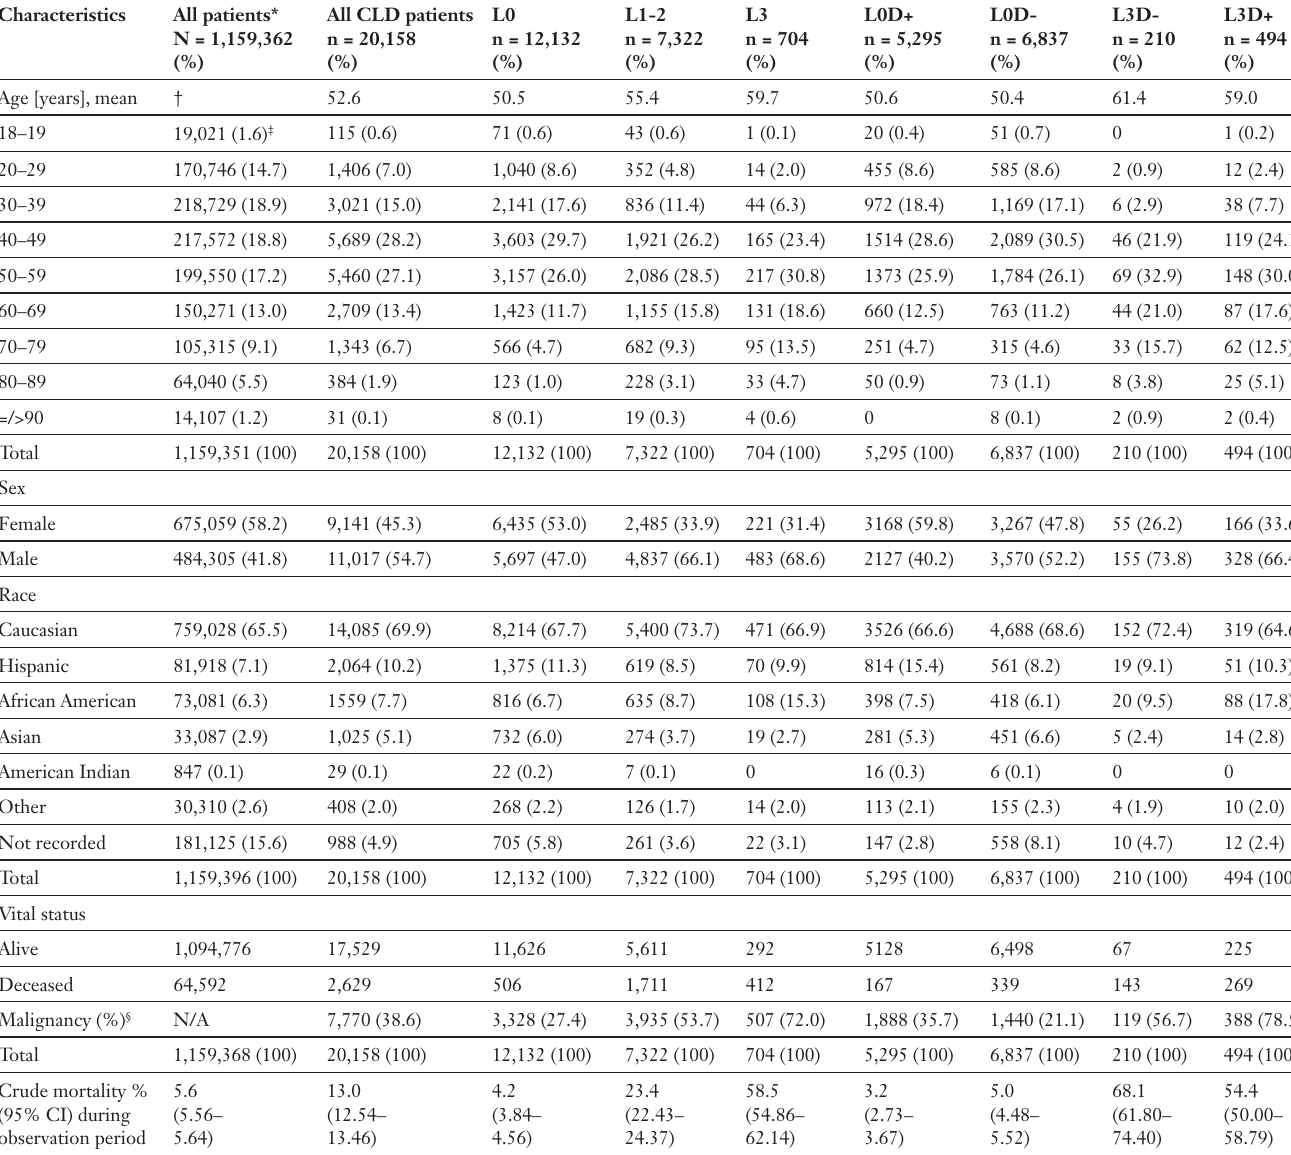
Characteristics and demographics of individual patients